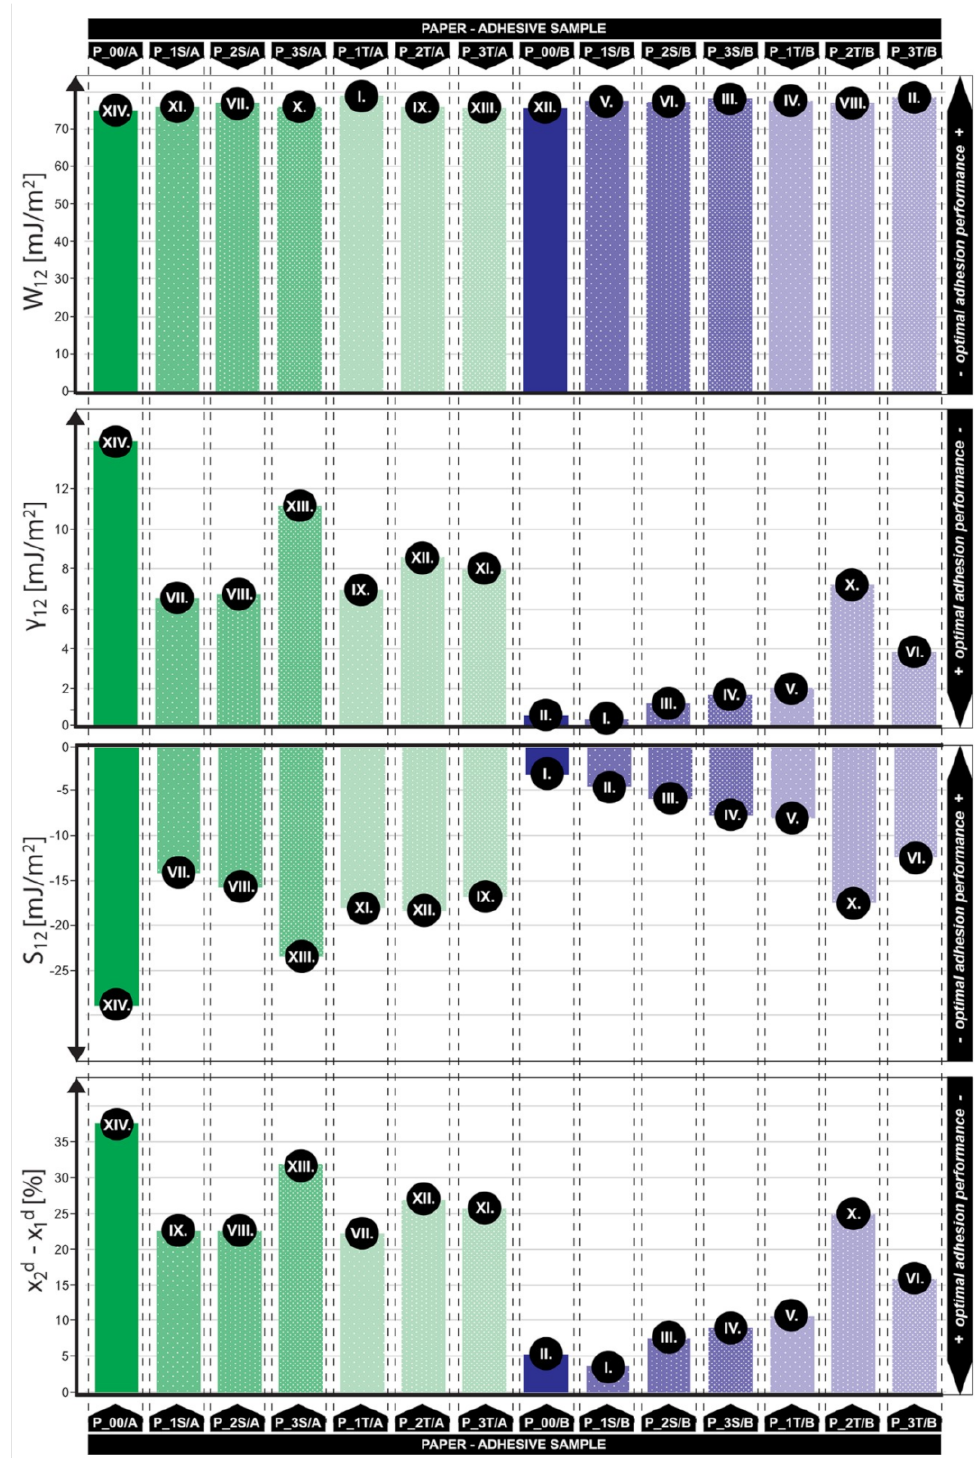
Figure 3. Adhesion performance results and rank according to work of adhesion ( W 12 ), SFE of interphase ( γ 12 ), wetting coe ffi cient ( S 12 ) and di ff erence between paper and paper-adhesive dispersive index ( x 2 d − x 1 d